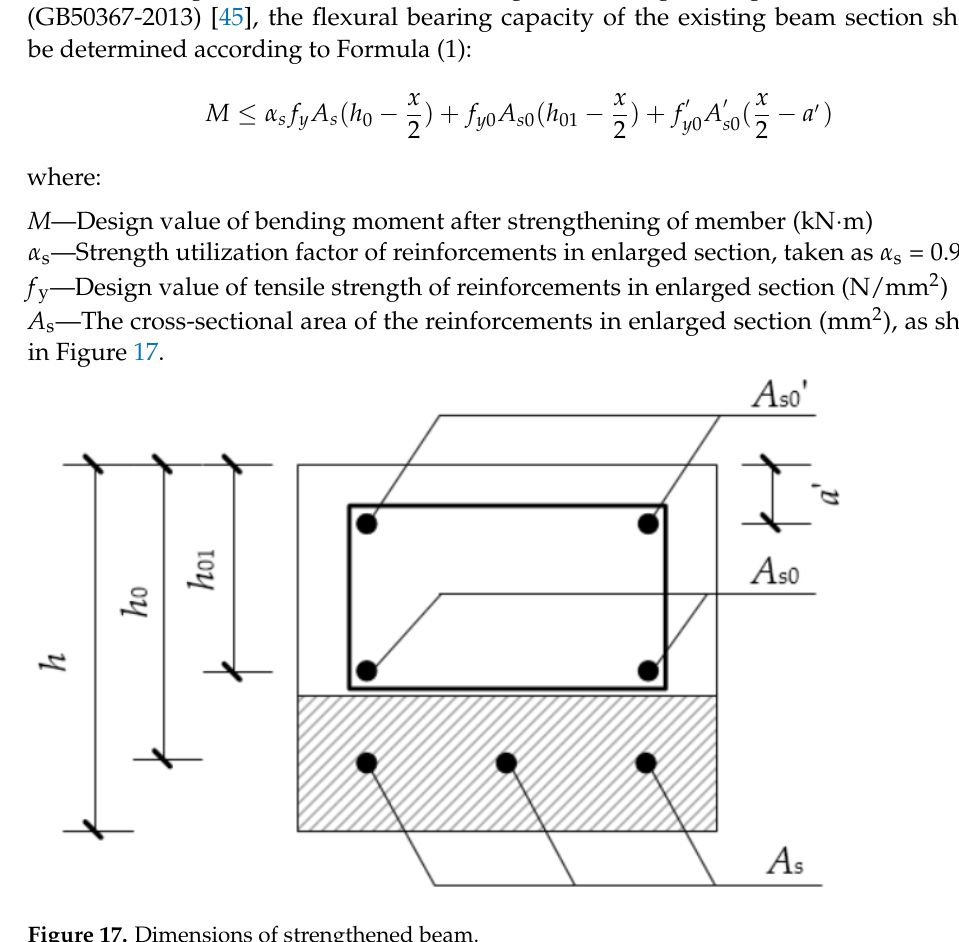
Figure 17. Dimensions of strengthened beam.